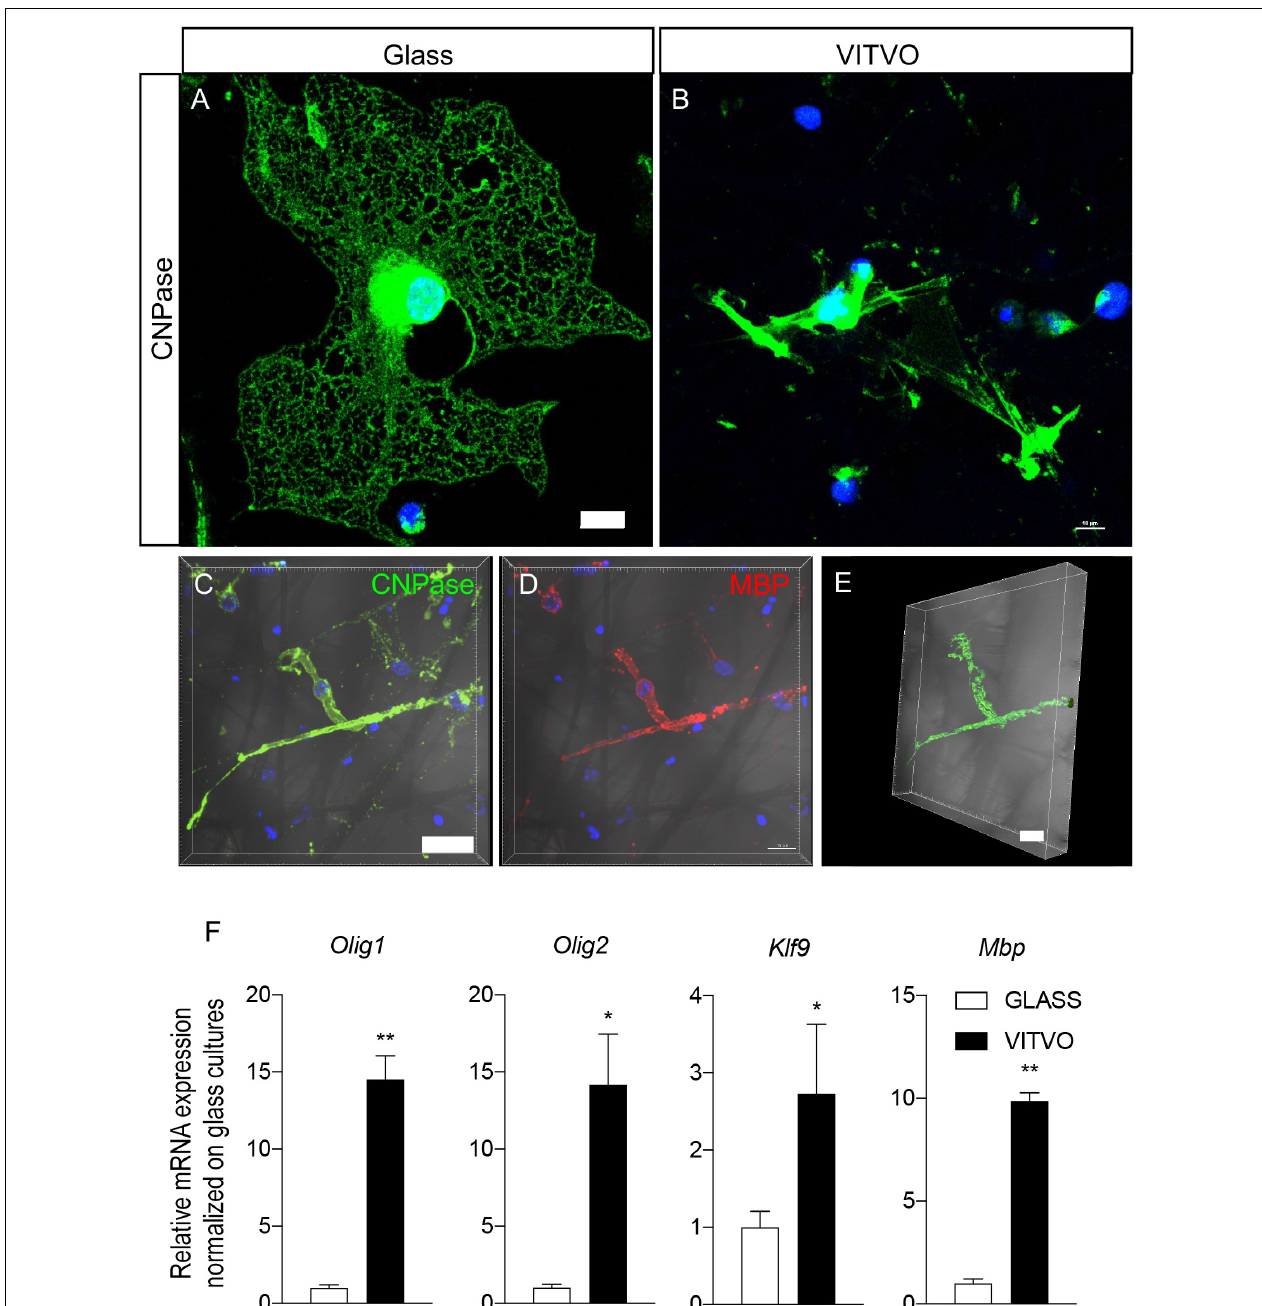
FIGURE 4 | (A,B) Representative images of mature oligodendrocytes seeded on laminin coated glass (A) or in VITVO (B) after 10 days in culture. Scale bar: 10 µ m. (C–E) Representative confocal images of neural stem cell-derived mature oligodendrocyte stained with CNPase (C) or MBP (D) showing the maximum intensity projection of the z-stack, and the IMARIS software elaboration (E) . The bright field is included in the pictures. Scale bar: 15 µ m (C,D) ; 10 µ m (E) . (F) Graphs represent expression of Mbp , Klf9 , Olig1, and Olig2 genes in neural stem cells seeded on glass or laminin after 10 days in culture. Statistical analysis: Student’s t -test. Asterisks represent differences between cultures seeded on glass or in VITVO (* p < 0.05; ** p <